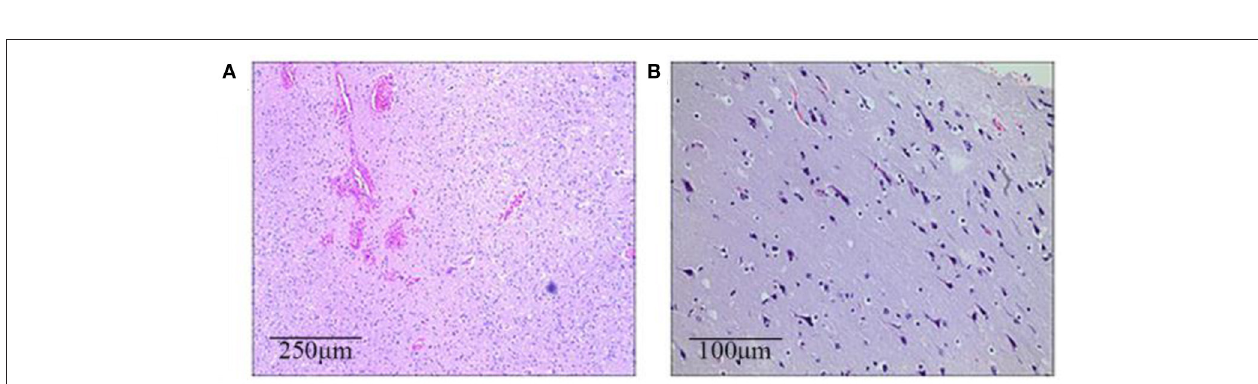
FIGURE 3 | MRI morphological analysis and postoperative CT of case 2 and case 3. The (A) FLAIR, (B) junction imaging, (C) normalized FLAIR signal intensity (NFSI), and (D) postoperative CT of case 2. The (E) FLAIR, (F) junction imaging, (G) NFSI, and (H) postoperative CT of case 3.